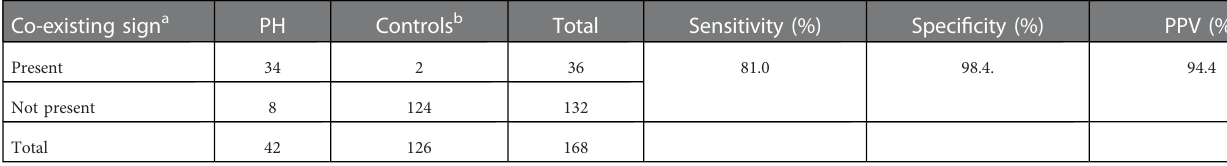
TABLE 3 The sensitivity and speci fi city of co-existing signs for PH diagnosis. Co-existing sign